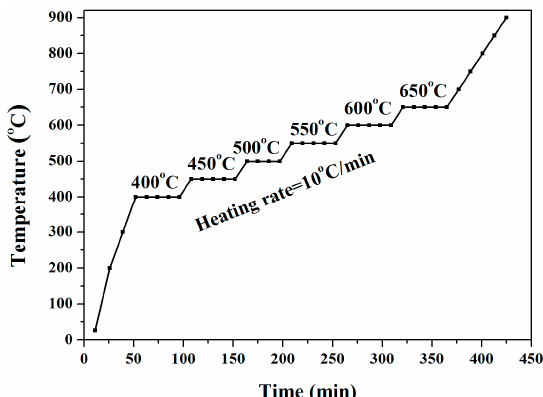
Figure 1. SRD heating protocol at 10 °C/min heating, 2 min/pattern acquired initially at ambient temperature, 100, 200, and 300 °C non-isothermally; 50 °C steps from 400 to 650 °C isothermally at 400,